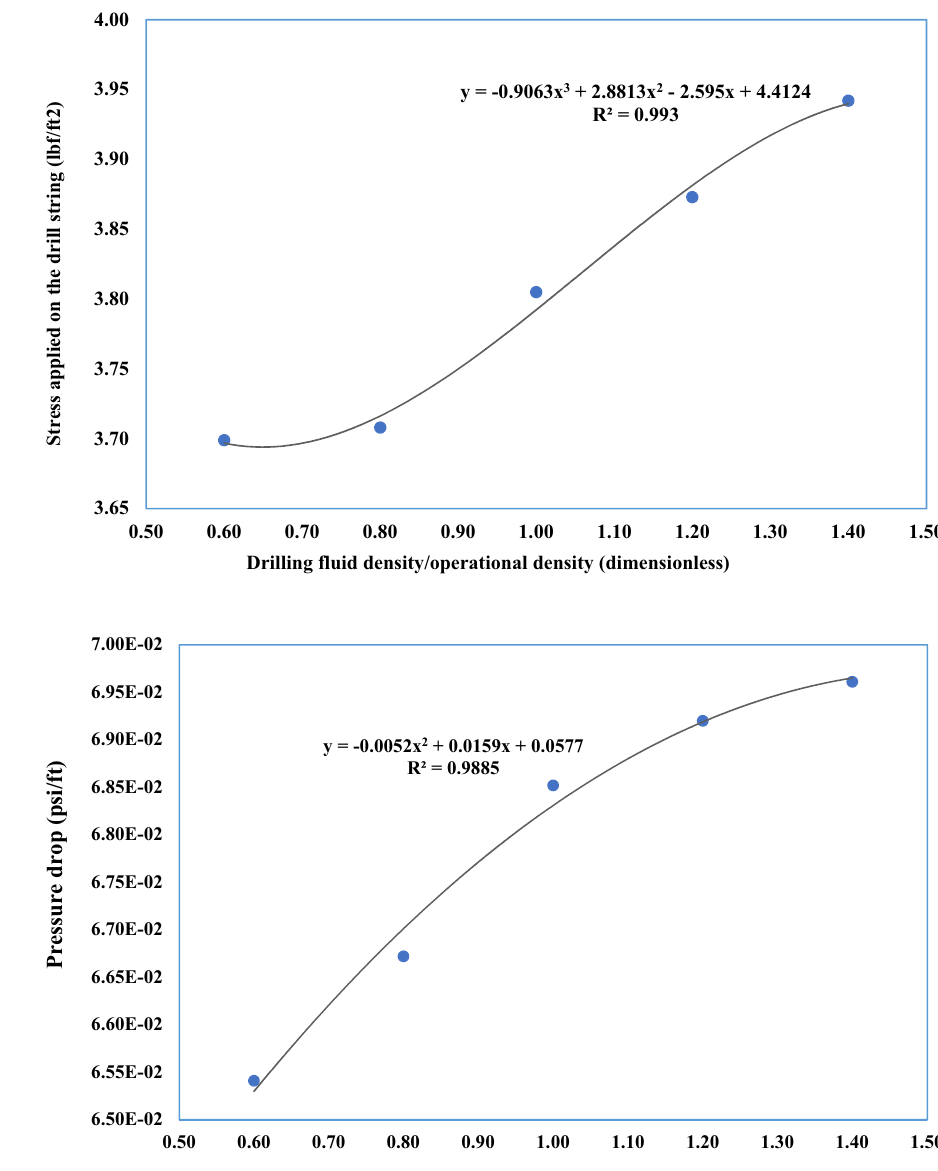
Fig. 18 Stress applied on the drill string versus drilling mud density